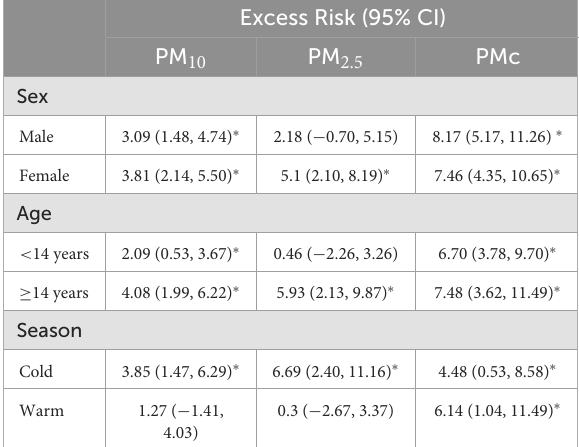
TABLE 3 Excess risk (%) and 95% CI of outpatient visits to fever clinics associated with a 10 µ g/m 3 increase in PM 10 , PM 2.5 , and PMc (lag03) concentrations, stratified by sex, age, and